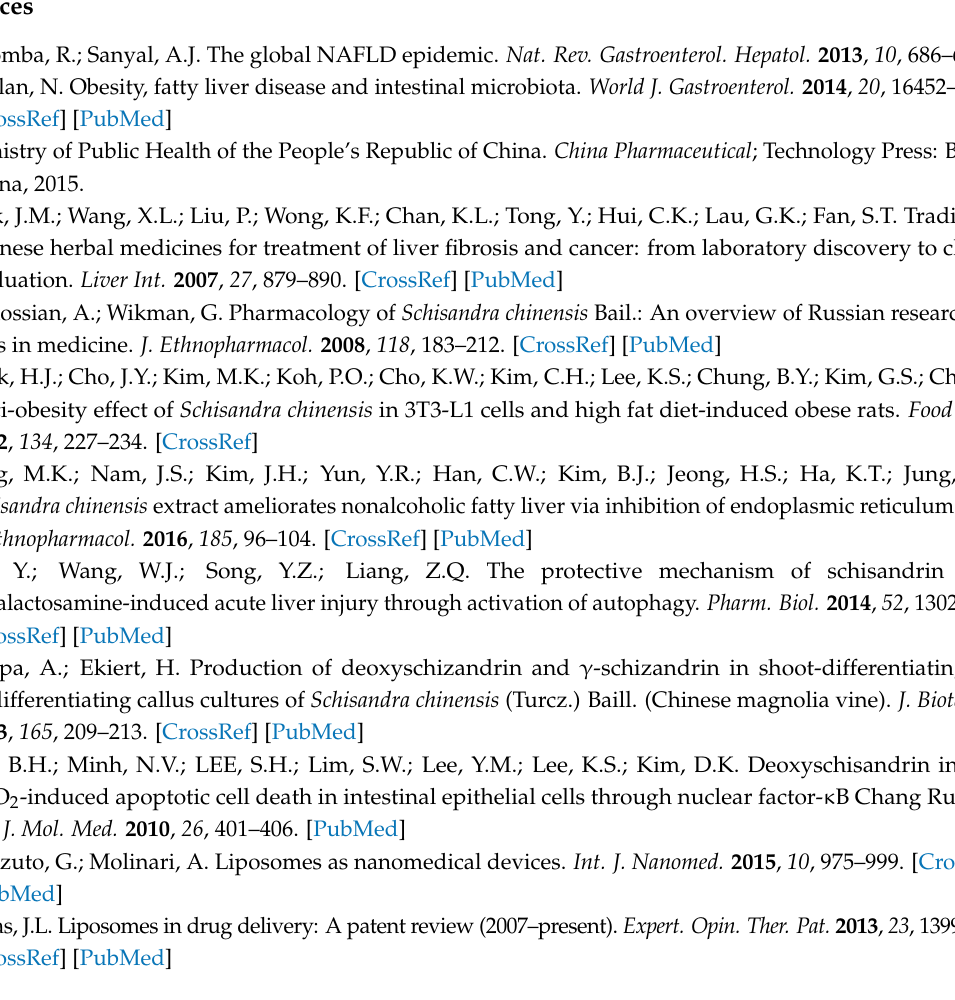
Figure S1: Single factor formulation optimization test of factor (A) and factor (B); Figure S2: Single factor formulation optimization test of